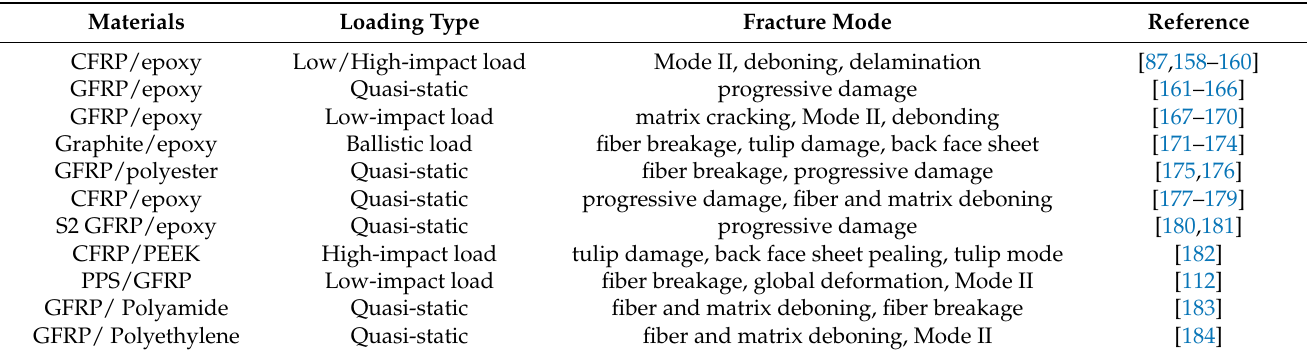
Table 1. Different failure modes for synthetic FRP composites.